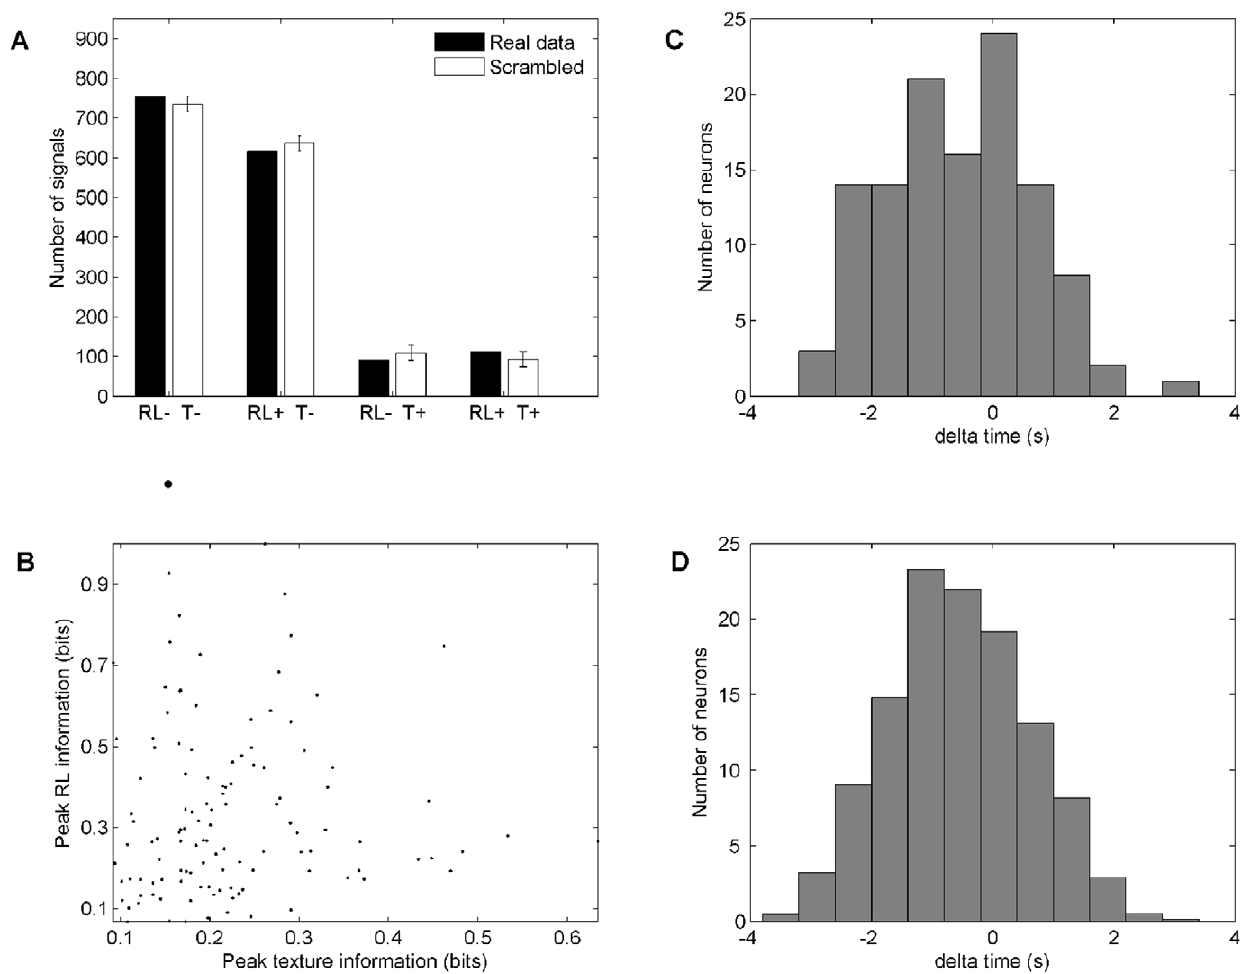
Figure 6. Relationship between texture signals and reward location signals. (A) Test to determine whether the presence of one type of signal predicted the presence of the other type. Black bars indicate the numbers of signals about neither texture information nor reward location information (RL + , T-), just one of the two (RL + , T- or RL + , T-), or both (T + , RL + ). Data from the two platforms were treated separately. The white bars indicate the count of signals that would be expected to carry given combinations of signals if texture and reward location were encoded independently, with 95 percent confidence intervals included. The simulated and observed distributions are identical. (B) Test to determine whether the strength of one type of signal predicted the strength of the other type. The analysis was applied to those neurons that carried significant quantities of both texture and reward location information (T + , RL + ) on the same platform. There was no significant correlation between the two (Spearman Rho =0.1, p =0.2). (C-D) Test to determine whether the time of occurrence of one type of signal predicted the time of occurrence of the other type. The upper panel shows the time of peak texture information - time of peak reward location information among neurons that carried both signals (T + , RL + ) on the same platform. The lower panel shows the same analysis, but time differences were measured between rather than within neurons, in 1,000 random combinations. The two distributions are equivalent, suggesting that within individual neurons there was no causal relationship between the appearance of the reward location signal and the appearance of the texture